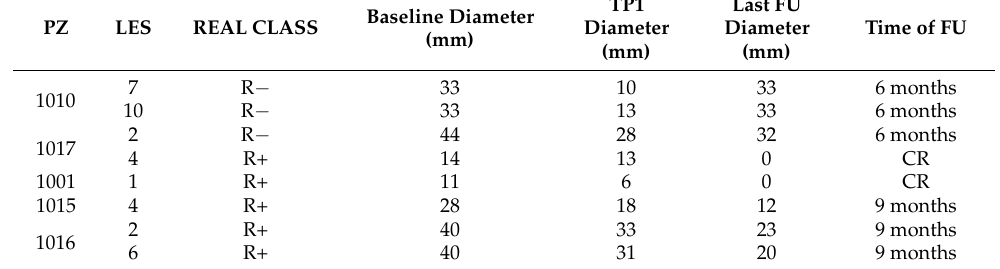
Table 2. Misclassified lesions of the validation set. Time of follow up (FU) is reported when the lesion is not in complete response.